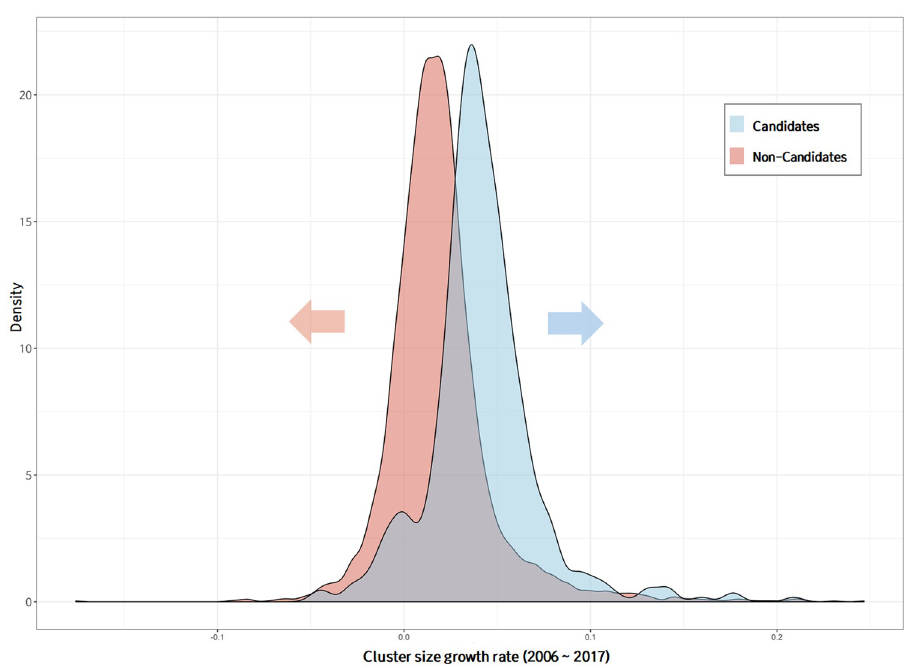
Fig 11. Comparison of growth rate distribution of technology clusters with and without high growth potential over all periods.